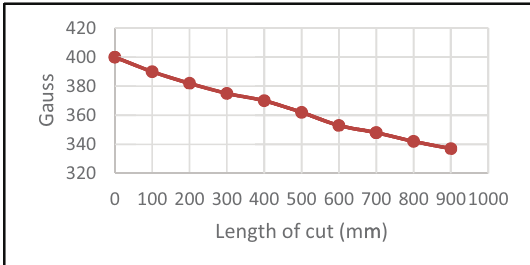
Figure 6: Magnetic fi eld change on tool tip during cutting.